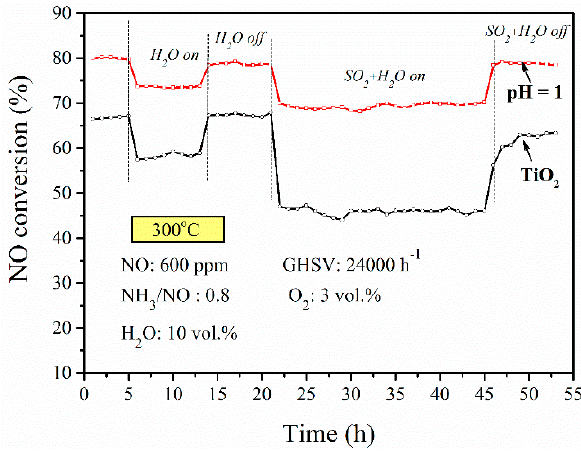
Figure 8. Resistance to poisoning of SO 2 and steam for the catalyst prepared with commercial TiO 2 support and BFS ‐ TiO 2 support made at pH = 1 of hydrolysis (2 wt. % V 2 O 5 , 5 wt. % WO 3 ).